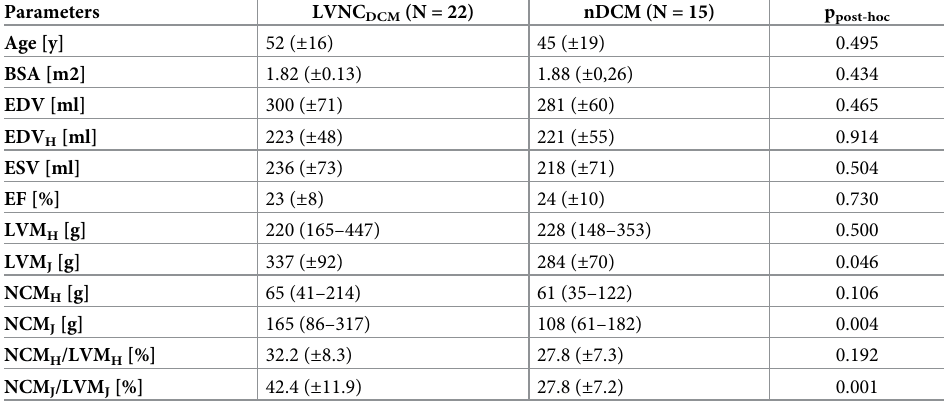
Table 6. Comparison of left ventricular noncompaction subgroup with enlarged left ventricle (LVNC DCM ) and dilated cardiomyopathy (nDCM) group.